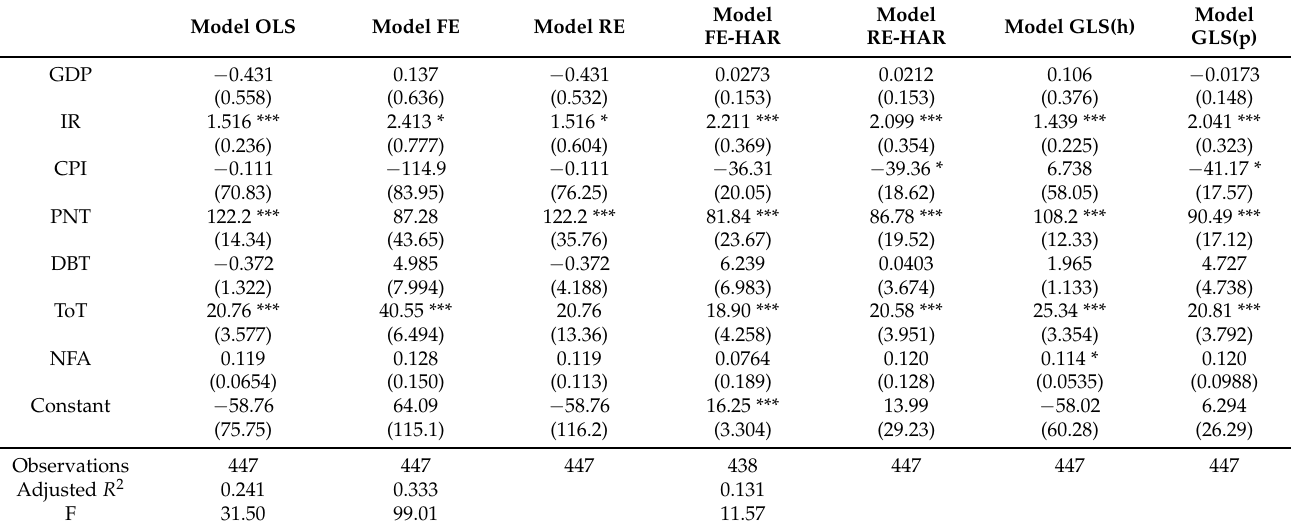
Table A16. Panel Regression Table AM Model 2 (Robust and HAR).